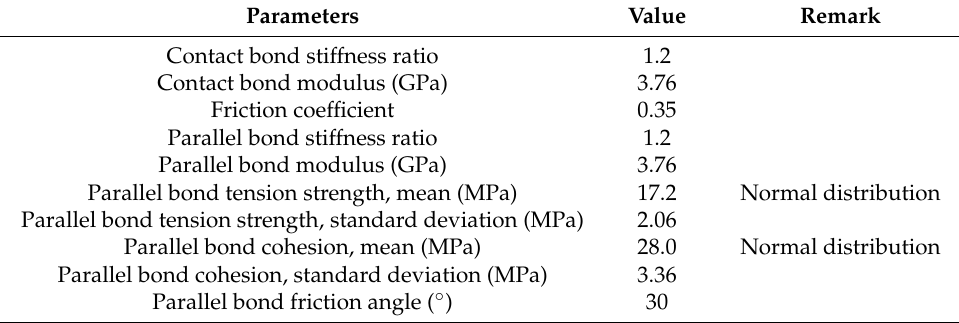
Table 1. Meso parameters of rock-like materials in PFC 2D model.